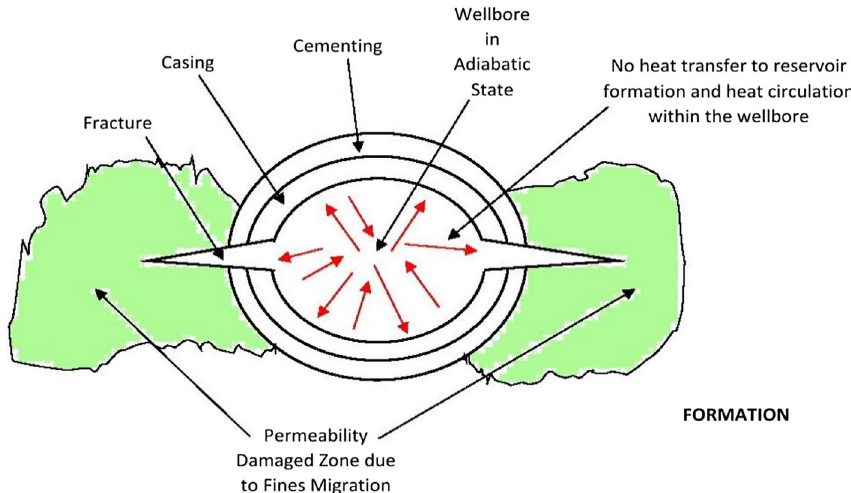
Fig. 4 Schematic diagram of adiabatic behavior of gas well due to migration and straining of natural reservoir fines